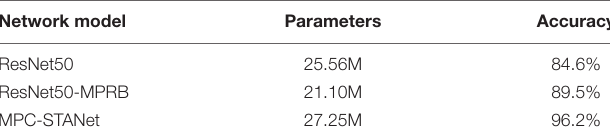
TABLE 4 | Comparison of accuracy and number of parameters of three networks.